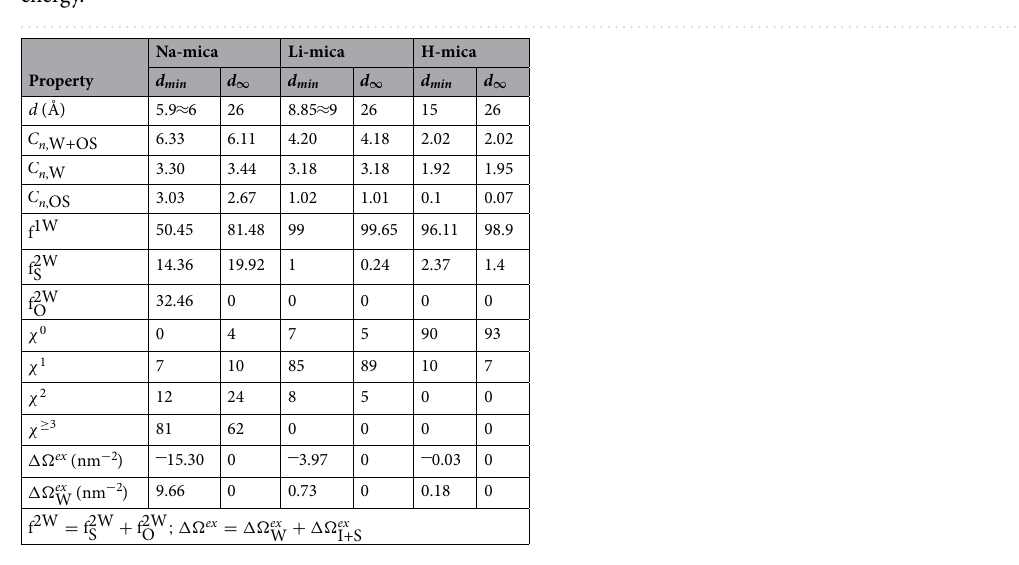
Table 2. Hydration statistics of cations and swelling free energies at d min and d ∞ for M-mica system.